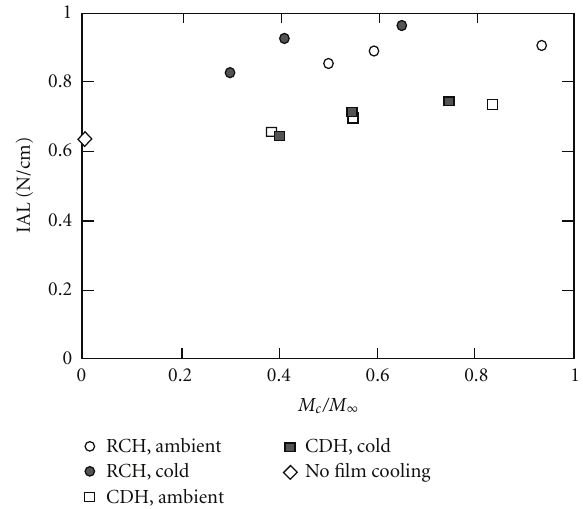
Figure 10: Comparison of integrated aerodynamic losses as dependent upon Mach number ratio from round cylindrical holes (RCHs) and conical di ff used holes (CDH), after correction for the presence of trailing edge oblique shock waves, for the symmetric airfoil with film cooling [54].